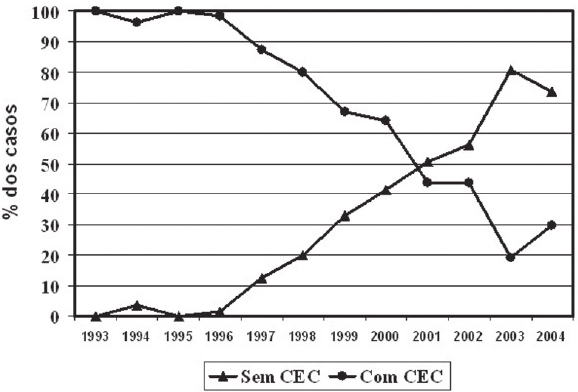
Fig. 3 – Evolução do número de cirurgias de revascularização